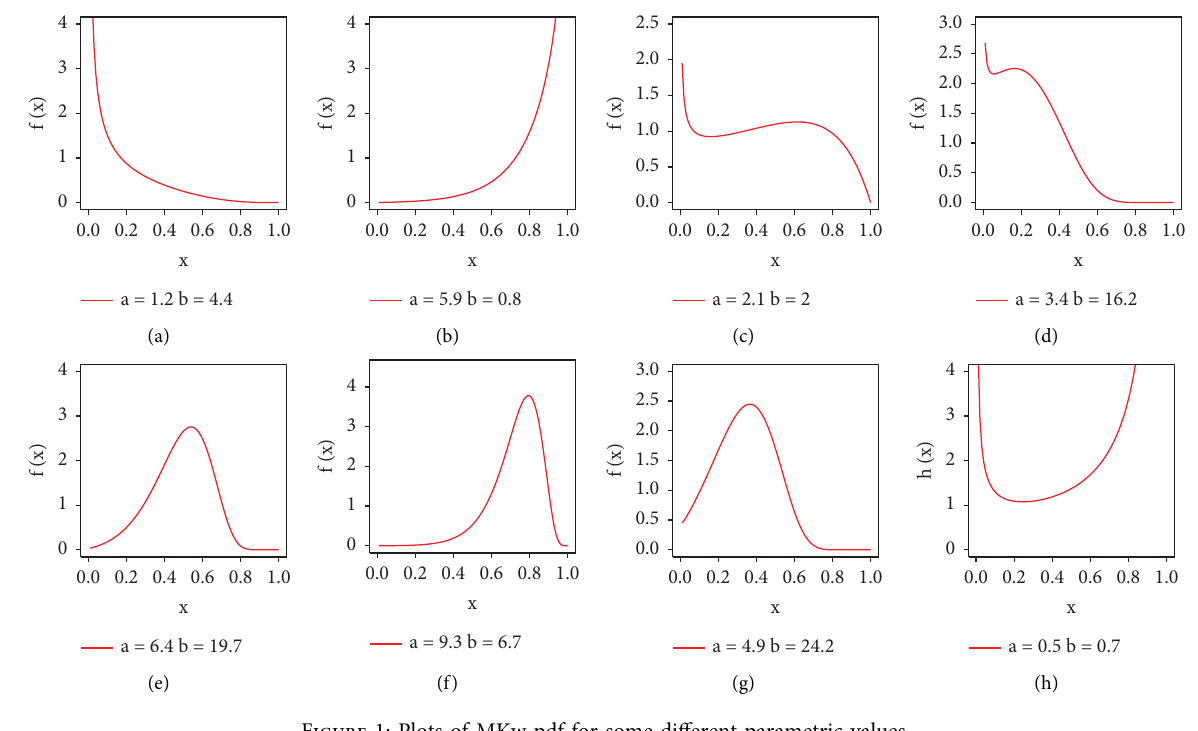
Figure 1: Plots of MKw pdf for some diferent parametric